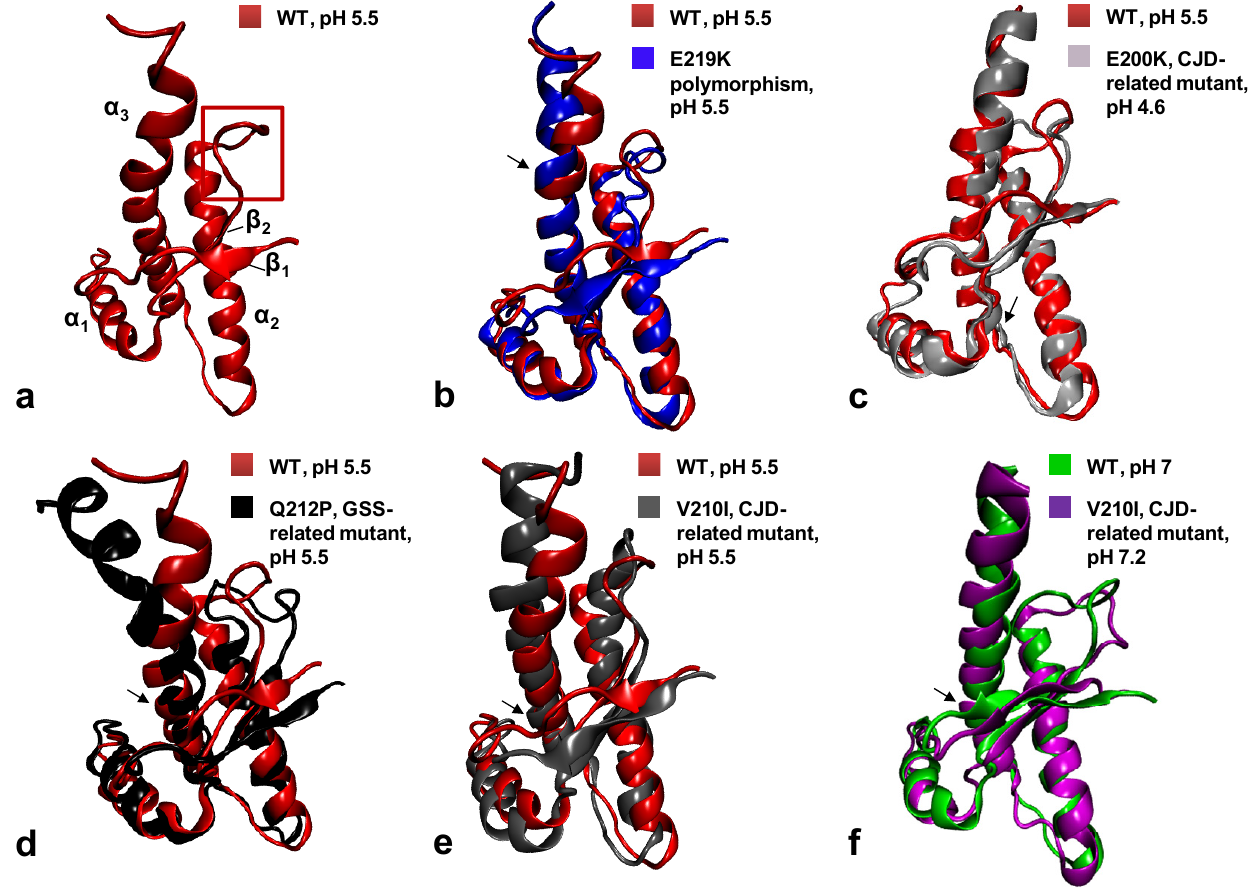
Figure 2. Cartoon representations and backbone heavy atom overlays of the different WT and mutants HuPrP folded domains (residues 126–231): WT at pH 5.5 in red ( a , PDB code 2LSB), E219K in blue ( b , PDB code 2LFT), E200K in light gray ( c , PDB code 1FO7), Q212P in black ( d , PDB code 2KUN), V210I at pH 5.5 in gray ( e , PDB code 2LEJ) and ( f ) V210I at pH 7.2 in magenta (PDB code 2LV1) superimposed with the WT at pH 7 in green (PDB code 1HJN). The red frame on the WT ( a ) highlights the β Black arrows point at the location of each mutation. WT, pH